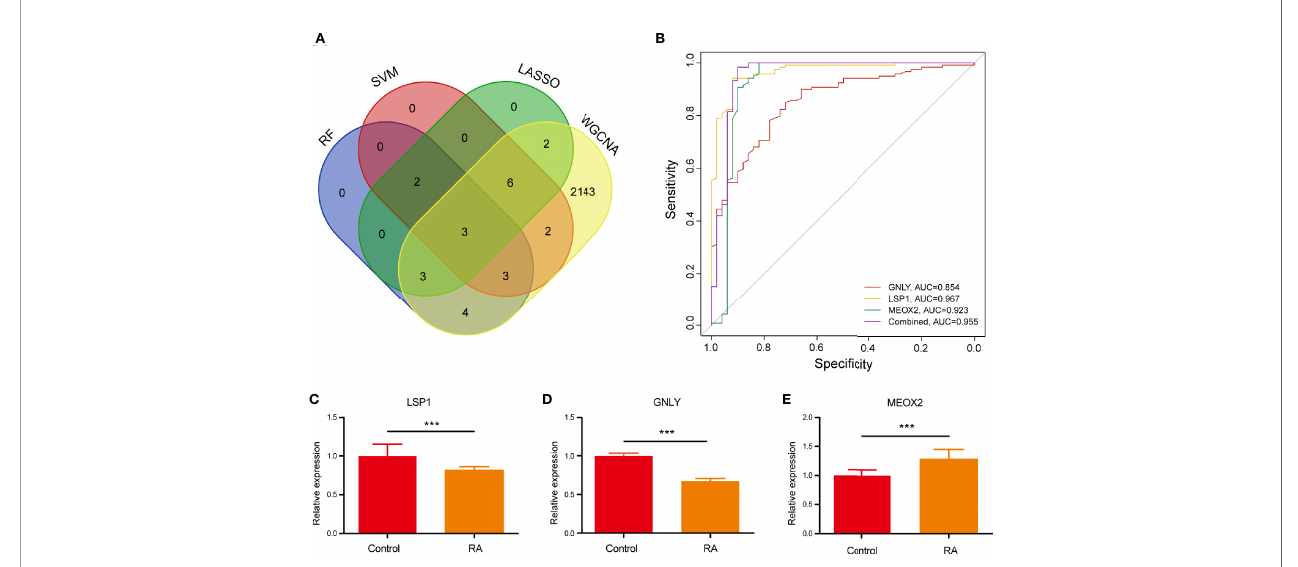
FIGURE 6 | (A) Venn diagram showed the intersection of diagnostic markers obtained by the four algorithms. (B) The ROC curve of the diagnostic ef fi cacy veri fi cation after fi tting three diagnostic markers to one variable. (C – E) The miRNA expressions of potential diagnostic markers were validated by qRT-PCR. ***P < 0.001.